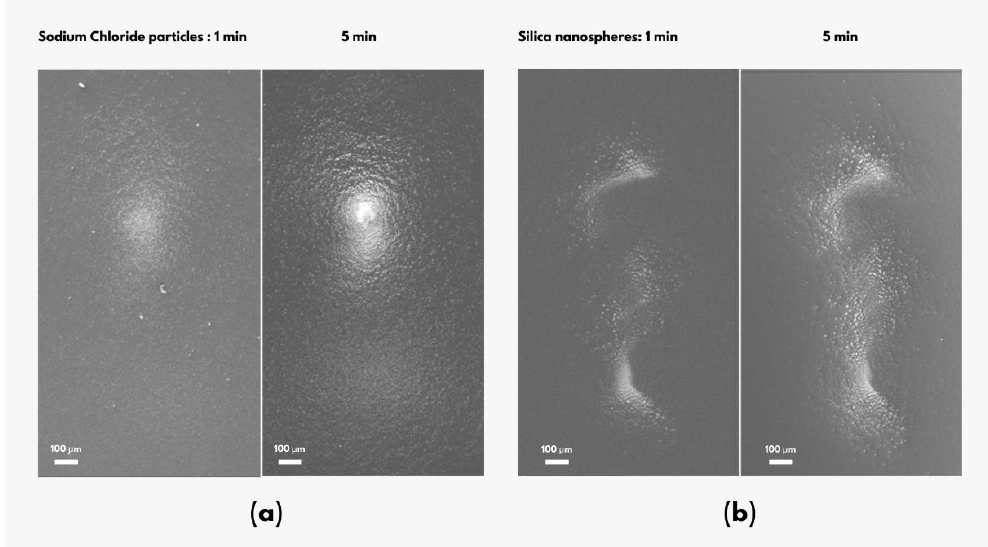
Figure 6. TSEM images (magnification: 50×, accelerating voltage: 15 kV) of the fine stage samples showing sodium chloride particles ( a ) and silica nanospheres ( b ) collected for 1 and 5 min, respec- tively.